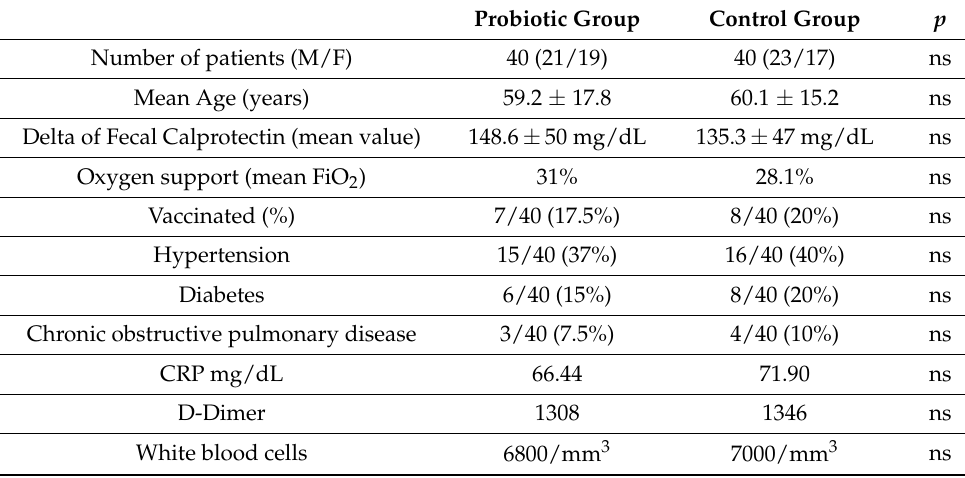
Table 1. Characteristic of patients at baseline (ns: not